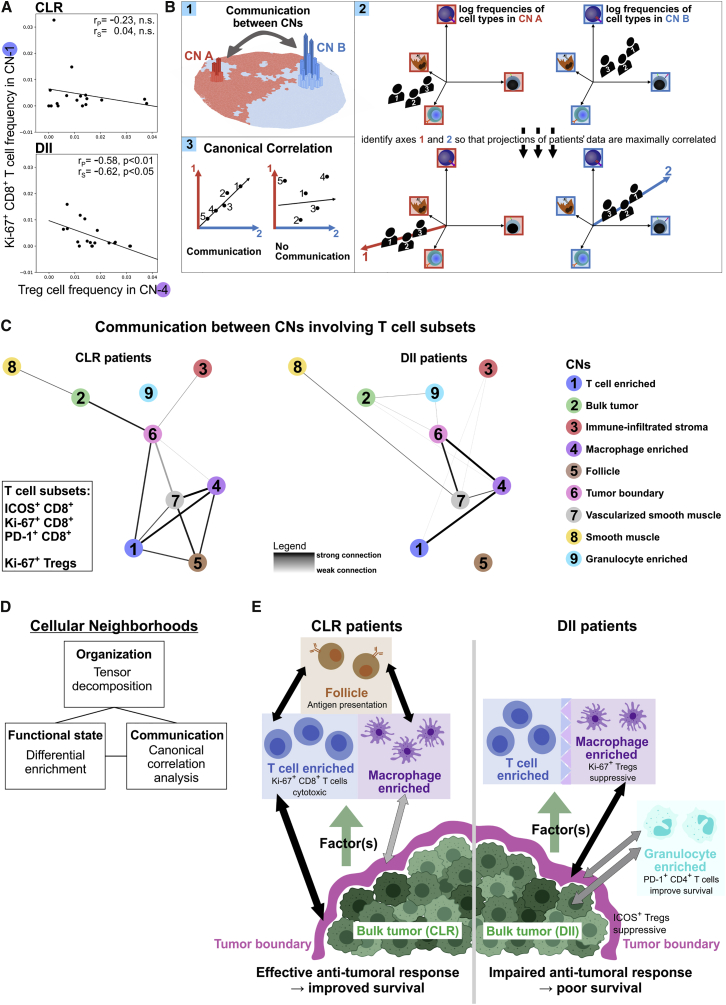
Altered Inter-CN Communication Favors Immunosuppression in DII Patients(A) Correlation of the frequency of Ki-67+CD8+ T cells in CN-1 (T cell enriched) and the frequency of Tregs in CN-4 (macrophage enriched) in each patient group. Spearman rank and Pearson correlation coefficients and p values are shown.(B) Schematic of the canonical correlation analysis (CCA).(C) The canonical correlation with respect to the frequencies of ICOS+, Ki-67+, and PD-1+ CD8+ T cells as well as Ki-67+ Treg cells in each pair of CNs was compared with a permuted null distribution within each patient group. Pairs of CNs whose observed canonical correlation with respect to these CTs was higher than 90% of permutations were connected by edges and visualized as a graph.(D) Conceptual framework for describing CRC iTME spatial behavior.(E) Model of differences in the iTME between CLR and DII patients with respect to CN organization (Figure 5), cellular function (Figure 6), and inter-CN communication (Figures 7A–7C).